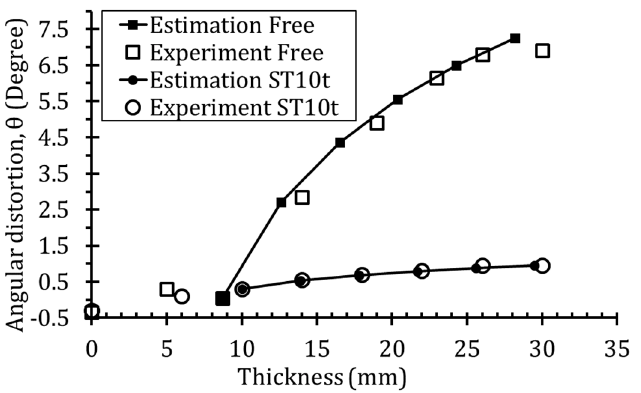
Figure 10. Comparison of experimental and predicted values in free (unconstrained) and constrained states for welding conditions of 285 A, 29 V, and 30 cm/min. (ST10t: strongback with 10 mm thickness).